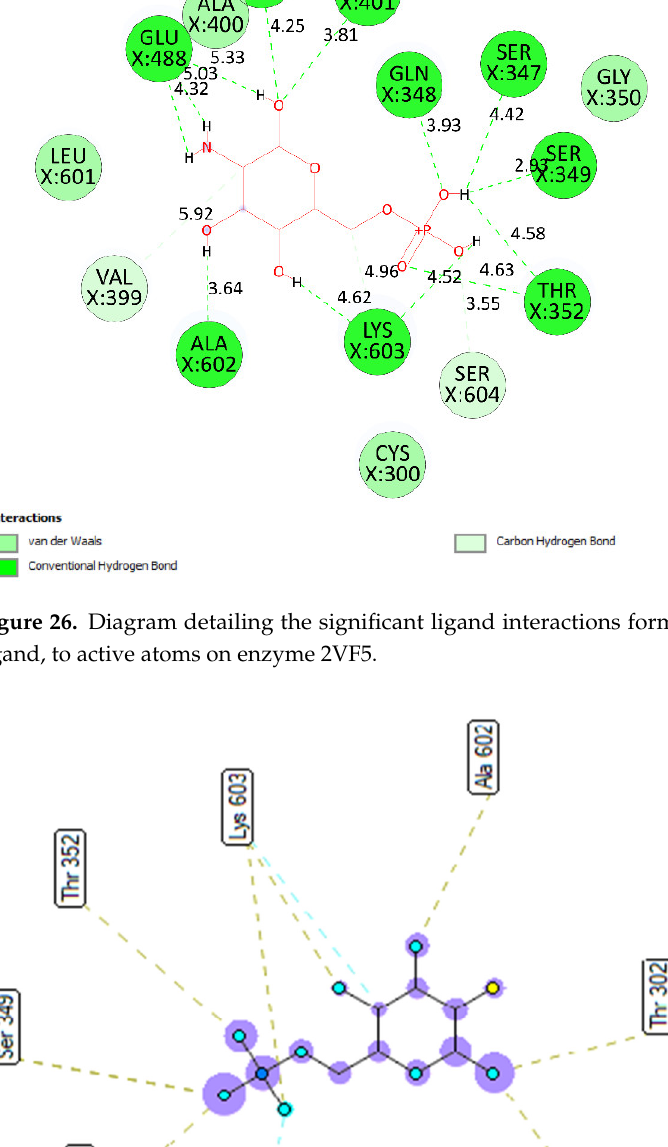
Figure 25. The hydrogen bonds from active atoms on pose 83, one small ligand which is available in enzyme 2VF5, to active residual amino acids on enzyme 2VF5.